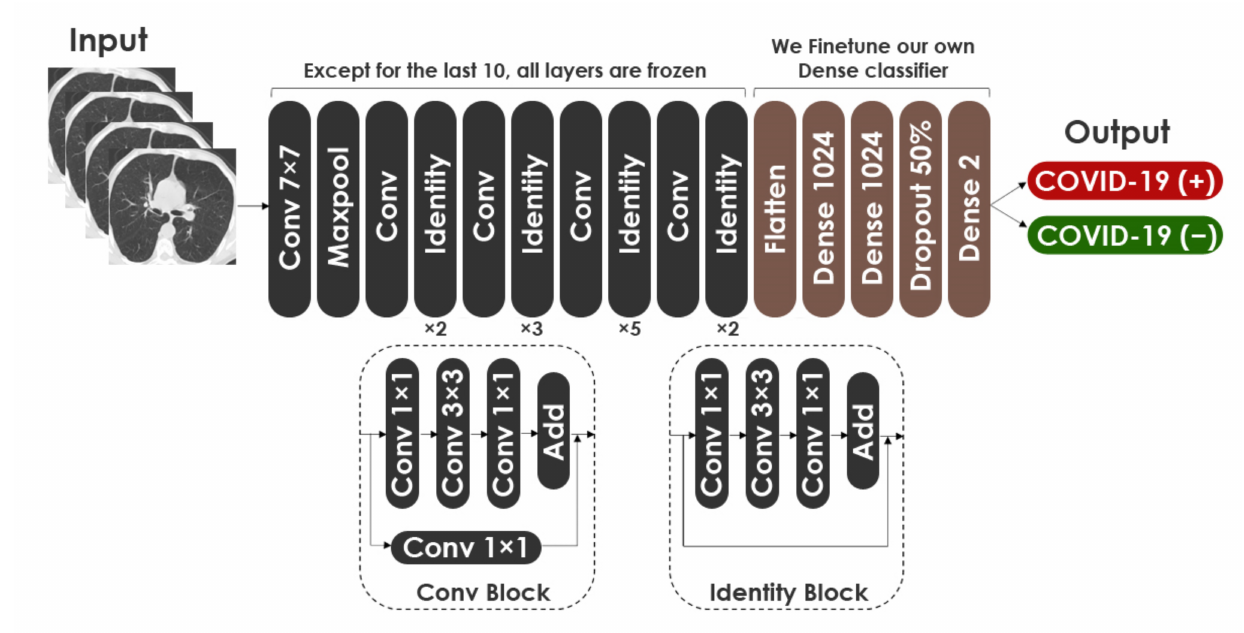
Figure 12. Architecture of modified ResNet50.